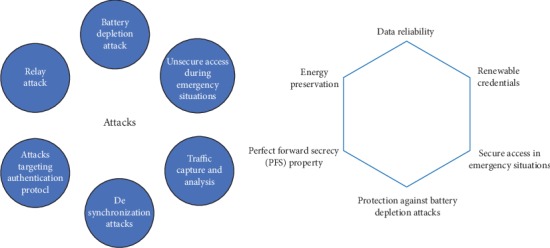
Security attacks and requirements for secure IMDs.